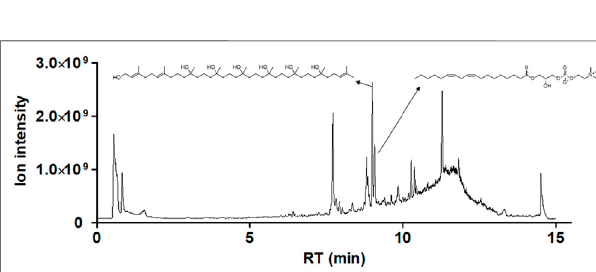
FIGURE 11 | Identi fi cation of the chemical compositions of WGM extracts. The chemical compositions of the WGM extracts were analyzed using UPLC-MS/MS analyses, MS data processing and Molecular networking – GNPS (http://gnps.ucsd.edu). There are only two components of WGM extracts which were identi fi ed by UPLC-MS/MS analysis,MSdataprocessingandMolecularnetworking – GNPS.Theretention time of (2 E ,6 E )-3,7,11,15,19,23,27,31,35-nonamethylhexatriaconta-2,6,34- triene-1,11,15,19,23,27,31-heptol and(18:2)lysophosphatidylcholineare8.9 and 9.0 min,